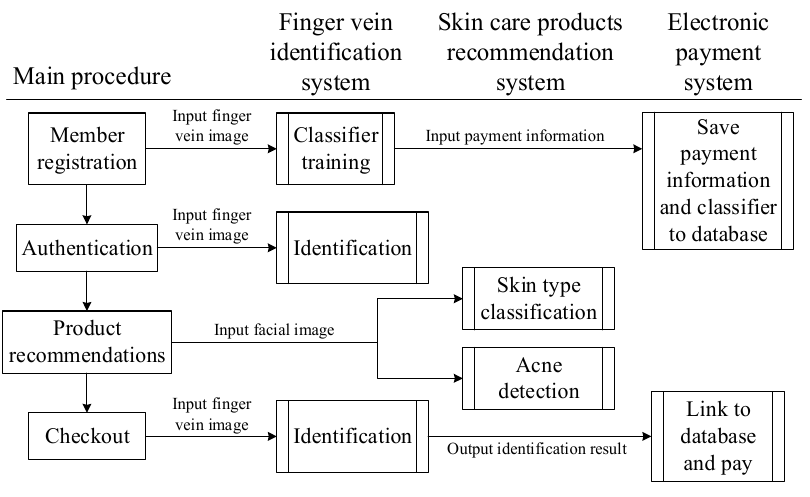
Figure 1. Flowchart of the main architecture.